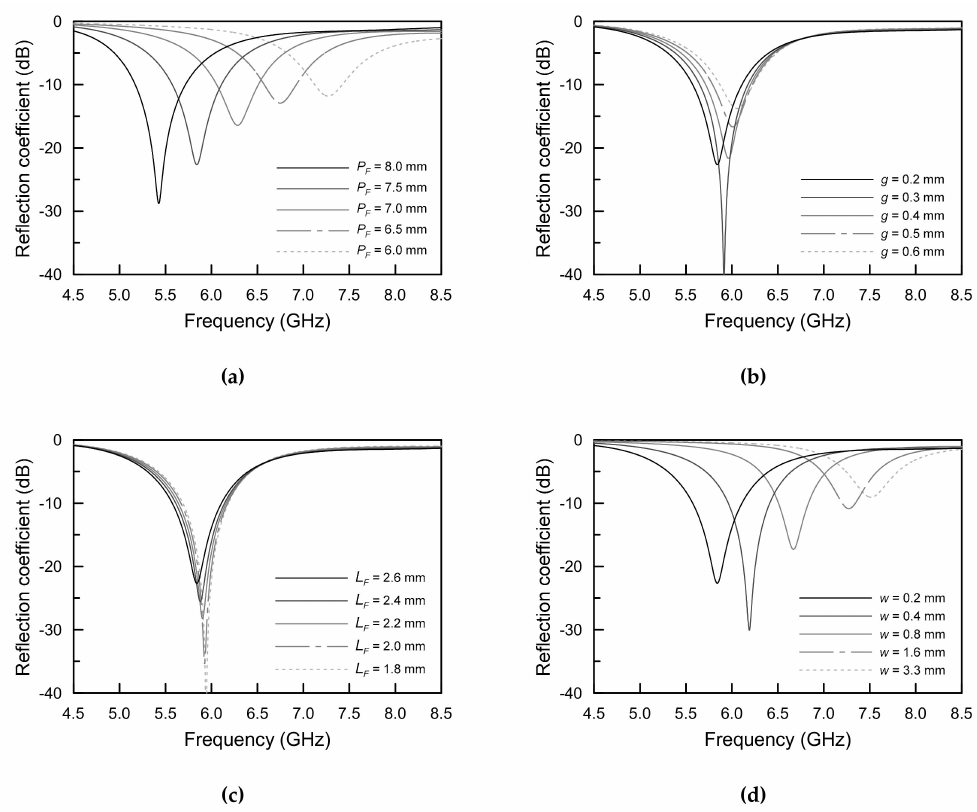
Figure 8. Reflection coe ffi cients of the proposed antenna from the parametric study: ( a ) the feeding patch size, ( b ) gaps between the feeding patch and radiator patch, ( c ) the ground feed pad space, and ( d ) the width of the meshed